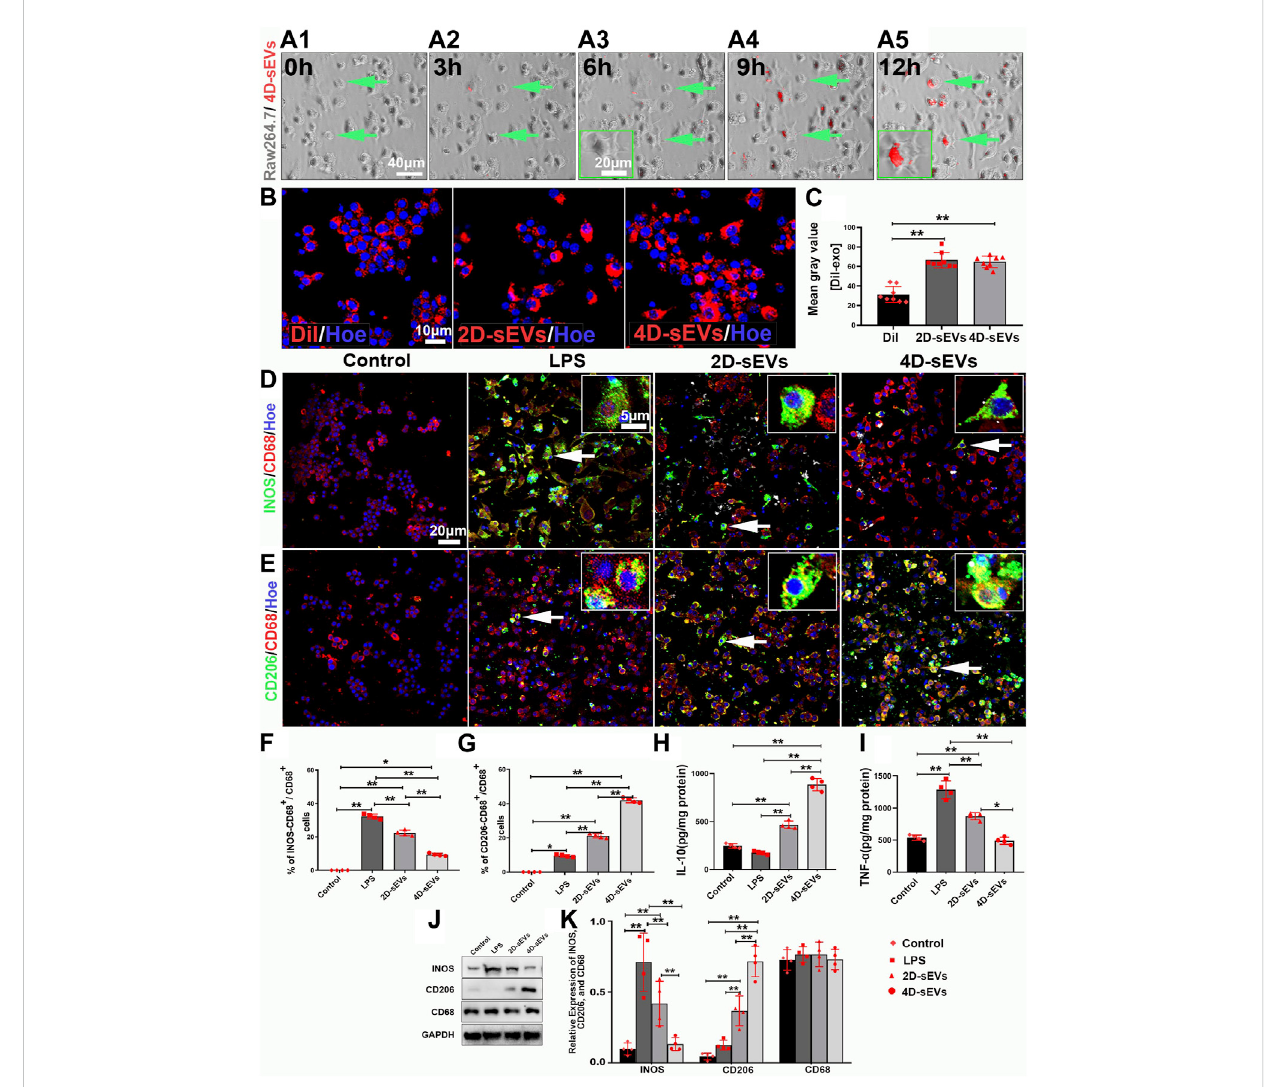
FIGURE 4 Four dimensional-derived sEVs promote LPS pre-induced activation of M1 to M2 type macrophage polarization in vitro . A1 – A5: Live-cell imaging system to observe the uptake of Dil-labeled sEVs in RAW264.7. (B) The fl uorescently stained images show that RAW264.7 cells uptake Dil dye and Dil- labeled sEVs. (C) Bar charts showing the mean fl uorescence intensity in vitro . (D – E) : Fluorescently stained images showing INOS + (green)/CD68 + (red) M1macrophagecellsandCD206 + (green)/CD68 + (red)M2macrophagecellsinthethreegroups,Control(non-LPS-induced)RAW264.7cellsdonot express INOS and CD206. (F) Bar charts showing that the ratio of INOS + /CD68 + cells to CD68 + cells. (G) Bar charts showing that the ratio of CD206 + / CD68 + cells to CD68 + cells. (H, I) : ELISA was performed to detect the concentrations of IL-10, and TNF- α from the supernatant of RAW264.7 cells. (J) Western blot analysis of protein expression (INOS, CD206, CD68) in vitro . (K) Quantitative analysis of Western blot. Statistic difference: * p < 0.05; ** p <